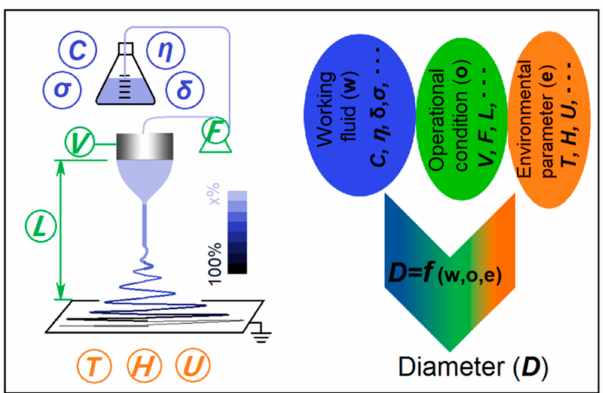
Figure 1. A diagram showing the single-fluid electrospinning process and the experimental parameters exerting influence on the diameters of the polymer nanofibers